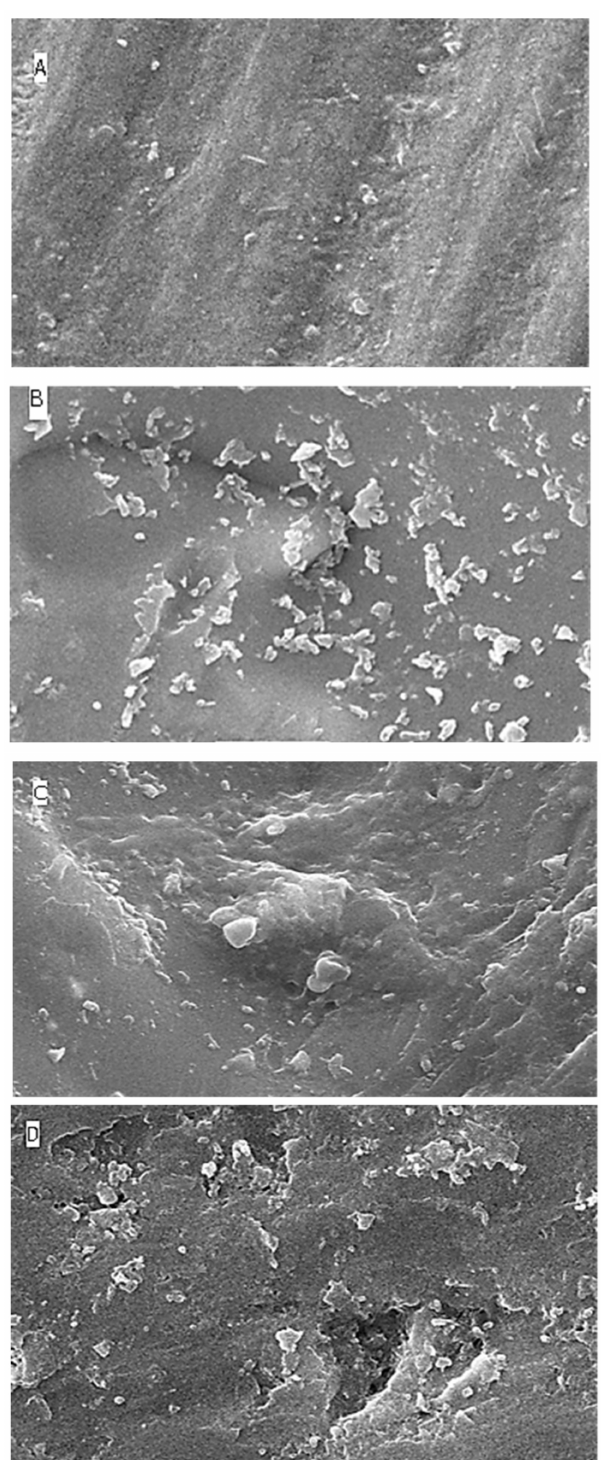
Figure 4. SEM images ( A – D ) of surface roughness at baseline, 24 h, 96 h and 168 h in distilled water. ( A ): Baseline SEM photomicrograph of IPS e.max ceramic before immersion in DW ( × 5000). ( B ): SEM photomicrograph of IPS e.max ceramic After 24 h immersion in DW ( × 5000). ( C ): SEM photomicro- graph of IPS e.max ceramic After 96 h immersion in DW ( × 5000). ( D ): SEM photomicrograph of IPS e.max ceramic After 168 h immersion in DW ( ×